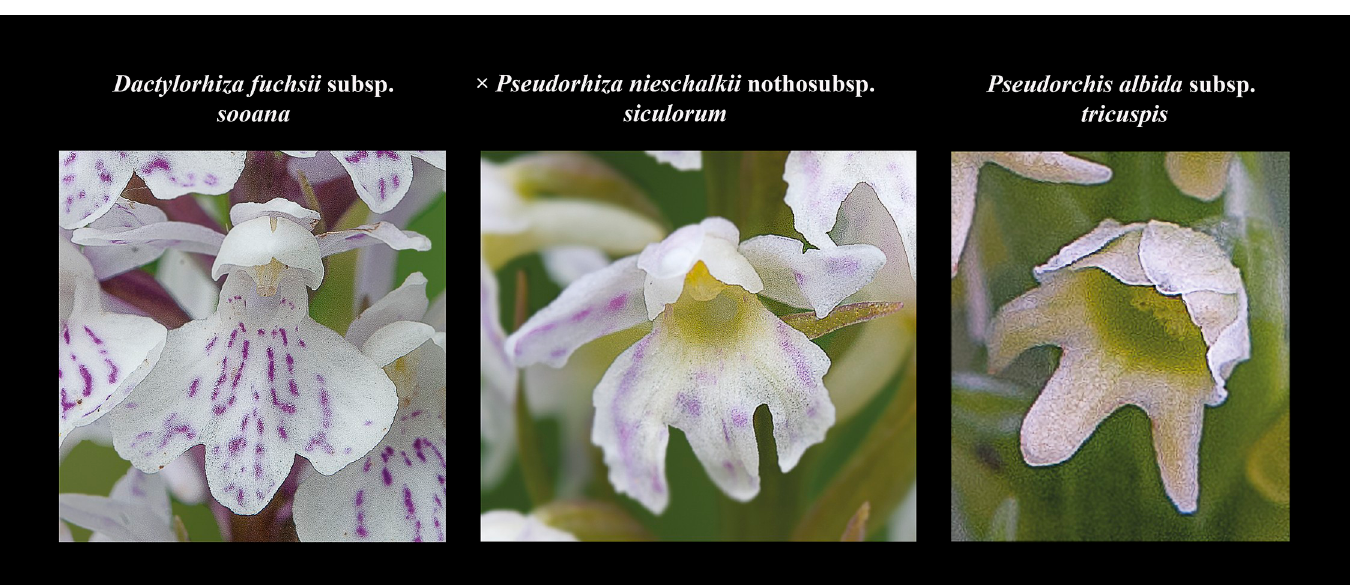
Fig 11. Morphological comparisons of × Pseudorhiza nieschalkii nothosubsp. siculorum and parents. The following three comparison diagrams show the intermediate characters of the hybrid’s habitus (Fig 9), inflorescence (Fig 10) and flowers (Fig 11), compared to those of its parents. The hybrids are almost as tall as the parents. The hybrid’s inflorescence is less floriferous and flat topped, resembling more that of D . fuchsii subsp. sooana parent. The flowers’ labellum is deeply three-lobed, very similar